Question: Write a single sentence explaining what this figure depicts.
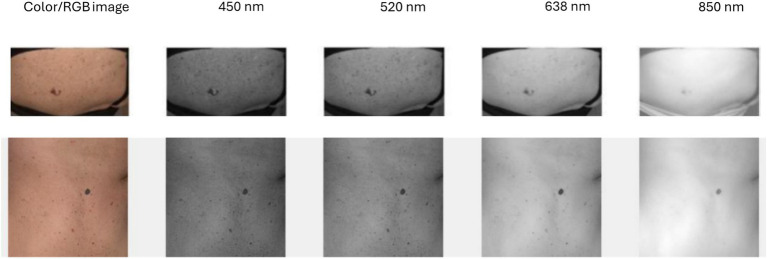
Answer: Comparison of spectral line images acquired from two cases of malignant melanoma surrounded by multiple nevi and photodamaged skin on the patients’ backs. While the visibility of the surrounding benign lesions progressively decreases with increasing wavelength, both melanomas remain clearly discernible in the 850 nm near-infrared image (NIR contrast persistence effect) ( 13 ).